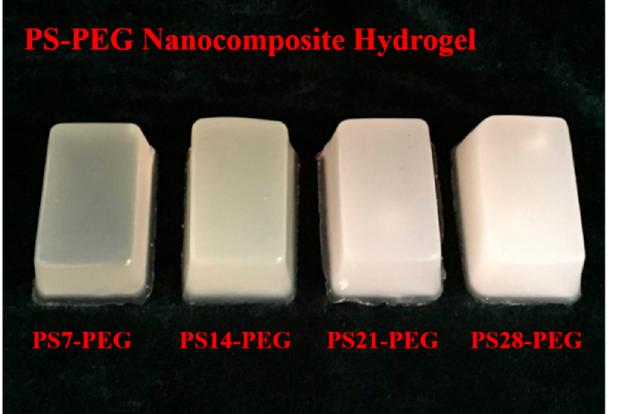
Figure 2. Macroscopic morphology of PS-PEG hydrogels.